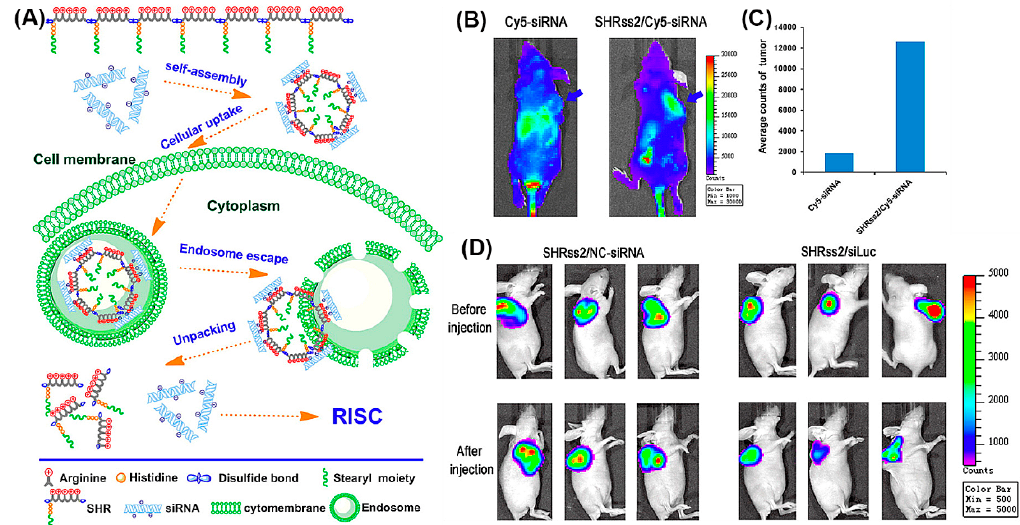
Figure 15. ( A ) Schematic illustration of self-assembly of cationic disulfide cross-linked SHRss and its complexation with negatively charged siRNA. ( B ) In vivo distribution and gene silencing efficiency of naked Cy5-siRNA and SHRss2/Cy5-siRNA nanocomplexes, after tail vein injection into xenograft tumor bearing mice after 4 h (blue arrows indicate the location of xenograft tumors). ( C ) Luciferase activity of the tumor tissue lysate after Cy5-siRNA and SHRss2/Cy5-siRNA nanocomplexes injections. ( D ) Luminescent images of tumors before and after SHRss2/NC-siRNA or SHRss2/siLuc nanocomplex injections. Reproduced from [173], with permission. Copyright: 2015 American Chemical Society.